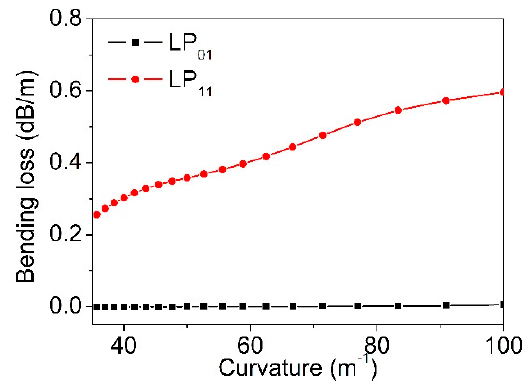
Figure 3. The simulation of two modes: Confinement loss when the curvature